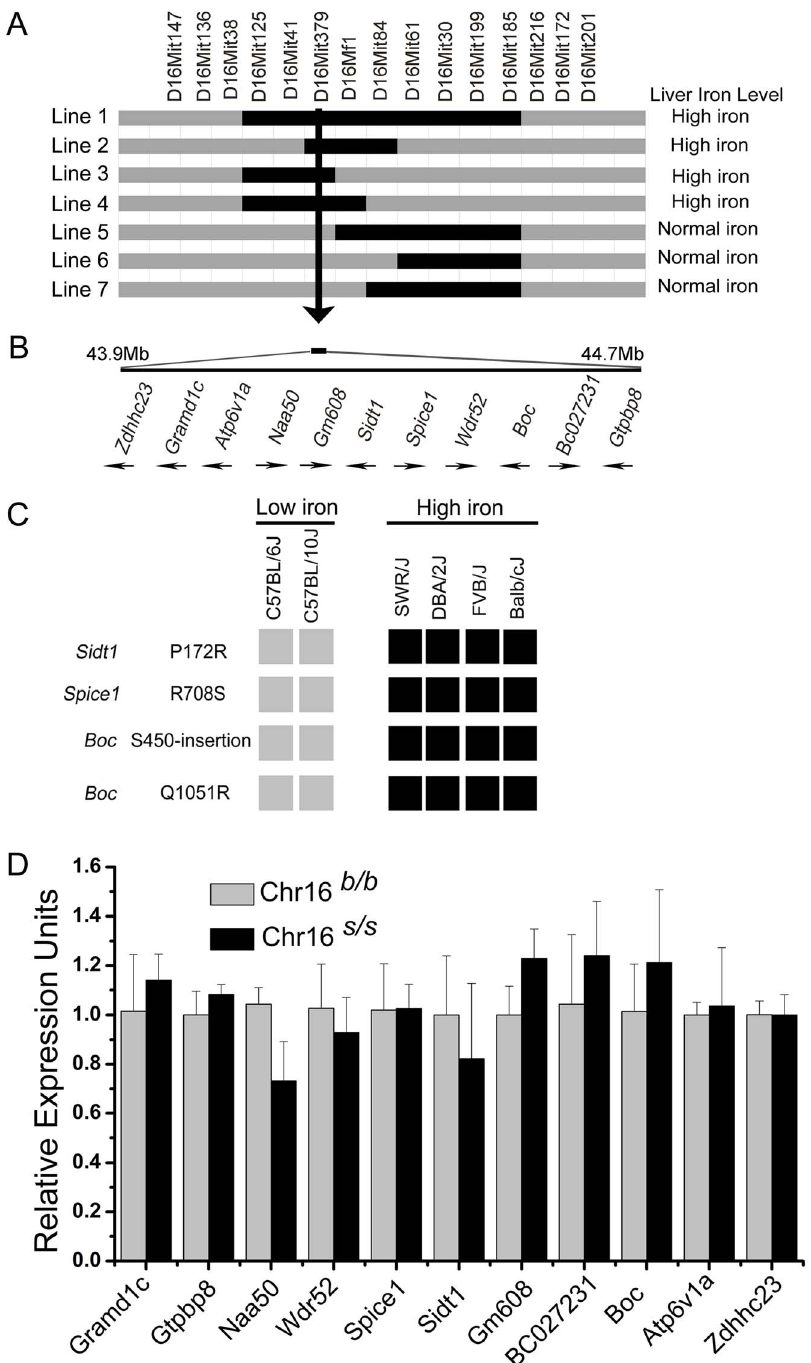
Figure 4. Fine mapping of the QTL on Chr16 and candidate genes in the critical interval. (A) Refinement of the Chr16 QTL location using sublines. Genotyping markers defining the boundaries are indicated across the top. The black portion of the lines indicates homozygosity for SWR alleles while grey indicates the B6 background. Liver iron status was grouped as normal (less than 55 mg/g) or high (higher than 70 mg/g) by an arbitrary cut-off and is shown on the right of each panel. (B) The critical candidate region was localized to an 840 kb region as indicated by the vertical arrow. Arrows indicate the direction of transcription. (C) Haplotype panel of inbred mouse strains for the four non-synonymous SNPs. Genotypes of SNPs were ascertained by direct DNA sequence analysis. Alleles identical to B6 alleles are shown in grey and alleles identical to SWR alleles are shown in black. (D) Relative mRNA expression of candidate genes in Chr16 congenic mouse liver. Expression of candidate genes is reported as relative expression levels using b -actin as an internal control in each group. The Chr16 s/s : Chr16 b/b ratios indicate relative expression levels of the Chr16 s/s group normalized to the Chr16 s/s group, which was defined as 1.0.